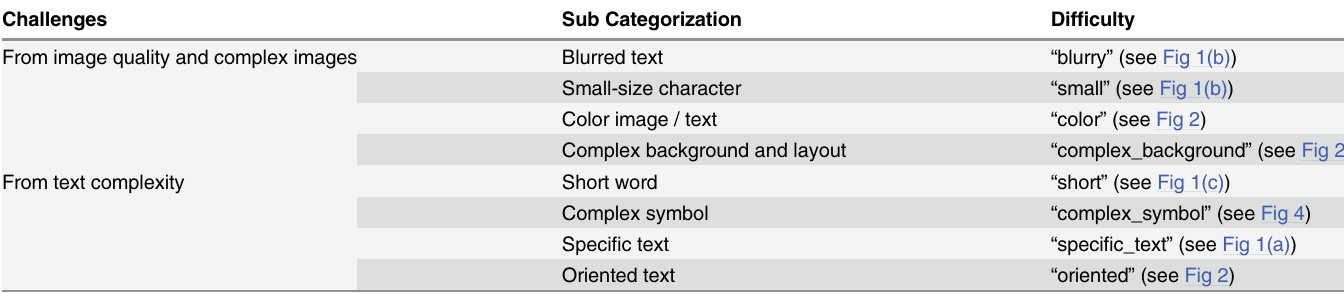
Table 8. Challenges for text detection and recognition from biomedical literature